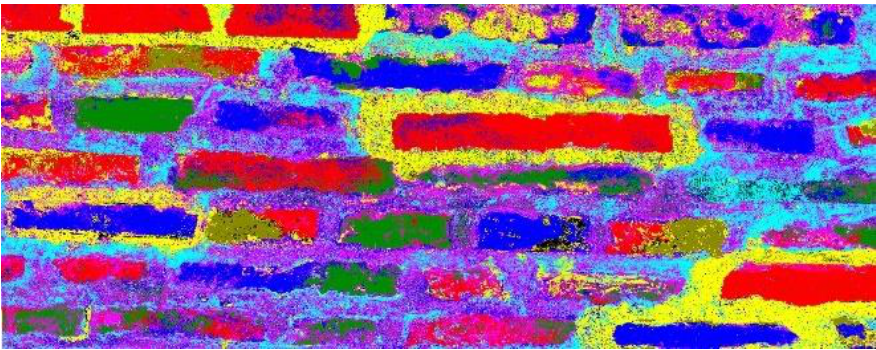
Figure 11. Spectral angle mapper (SAM) classification.